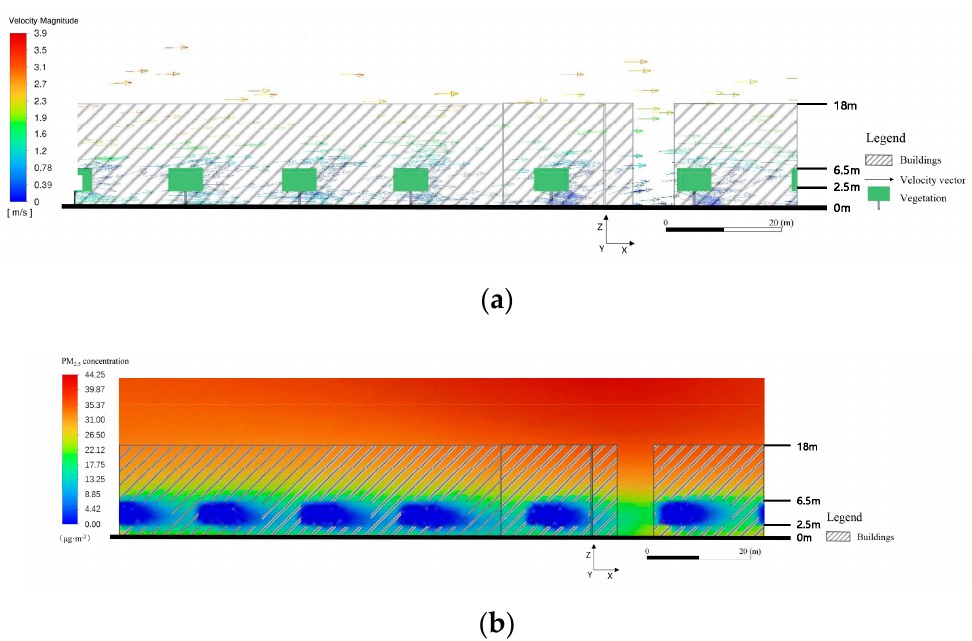
Figure 10. XZ plane in the local area of Neighborhood A of: ( a ) velocity vector; ( b ) PM 2.5 concentration distribution.